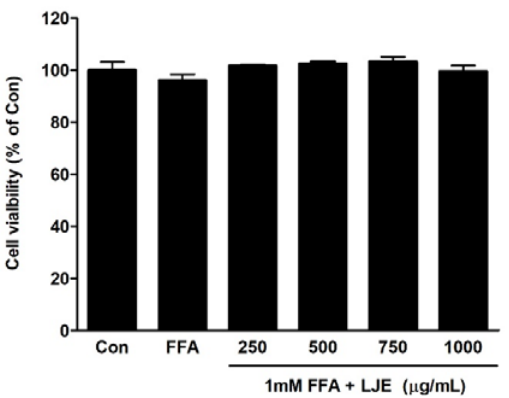
Figure 1. Effects of L. japonicus ethanol extract (LJE) on the viability of HepG2 cells. HepG2 cells were exposed to various concentrations of LJE and 1 mM free fatty acid (FFA). Data represent means ± SEM of three independent experiments.